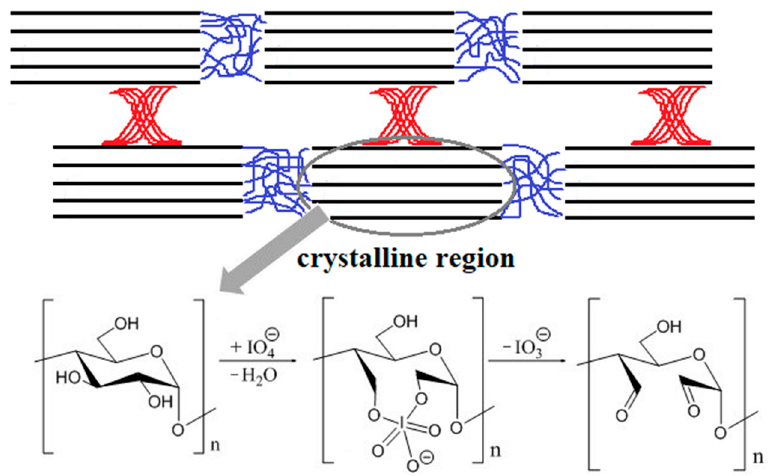
Figure 1. Scheme of the oxidation of nanocrystalline starch with sodium periodate.